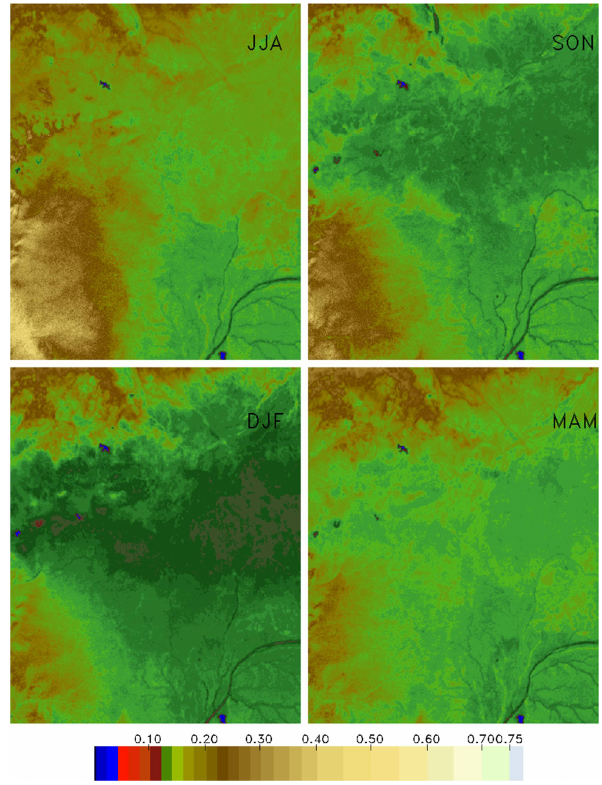
Figure 13. Background albedo maps for the four seasons. DJF (bot- tom left), MAM (bottom right), JJA (upper left) and SON (upper right).